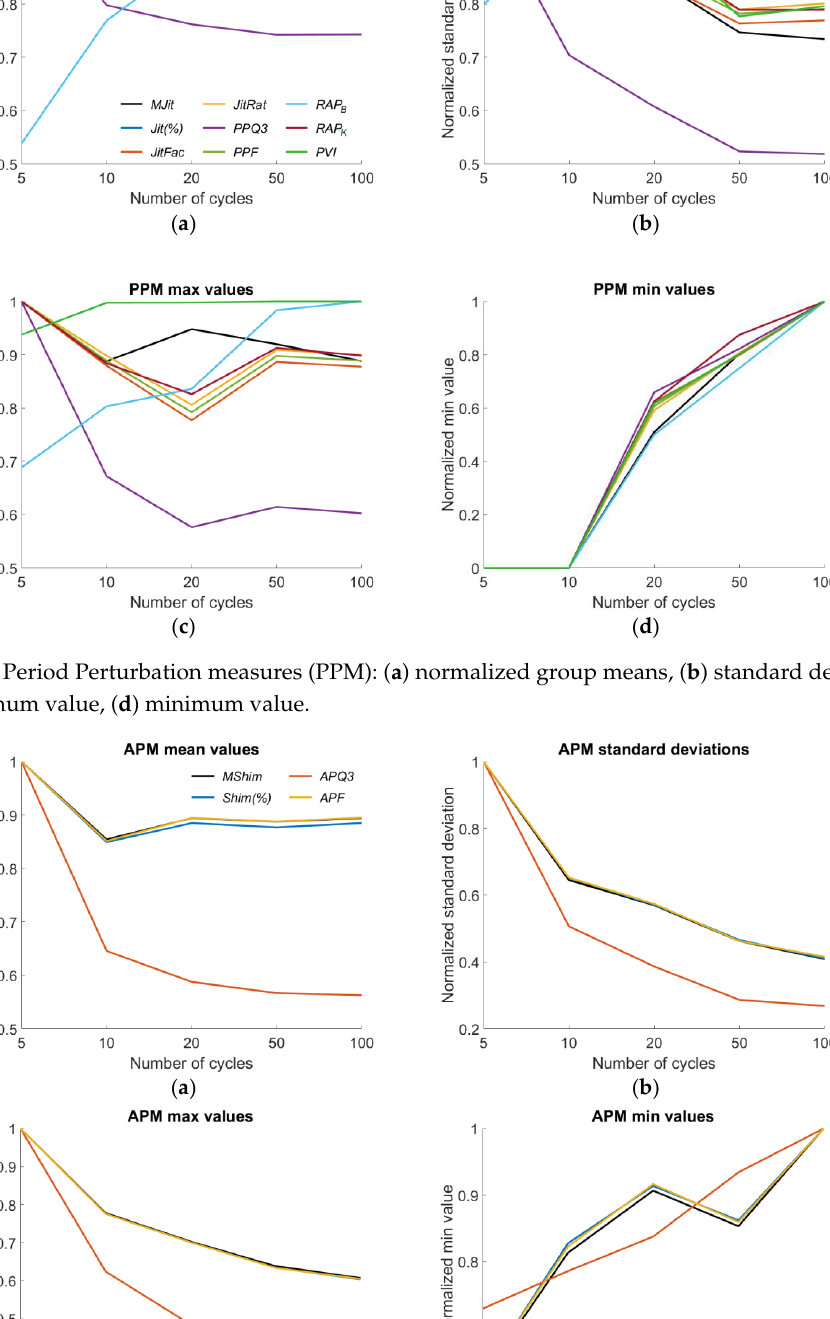
( d ) Figure 7. Energy Perturbation measures (EPM): ( a ) normalized group means, ( b ) standard deviation, ( c ) maximum value, ( d ) minimum value. The descriptive values for amplitude perturbation are depicted in Figure 6. The AVI was excluded from this figure since it can become negative and was hence not suitable for relative comparison. In other words, if AVI would be normalized in the same way as the other parameters, it would map to a number space outside the 0 to 1 interval.